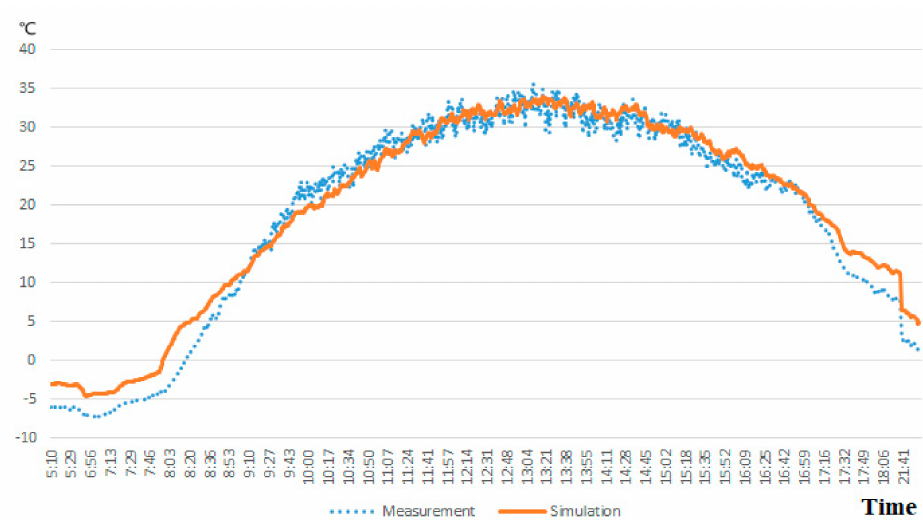
Figure 8. Graph of the measurement values and predicted values of the other module (02 March